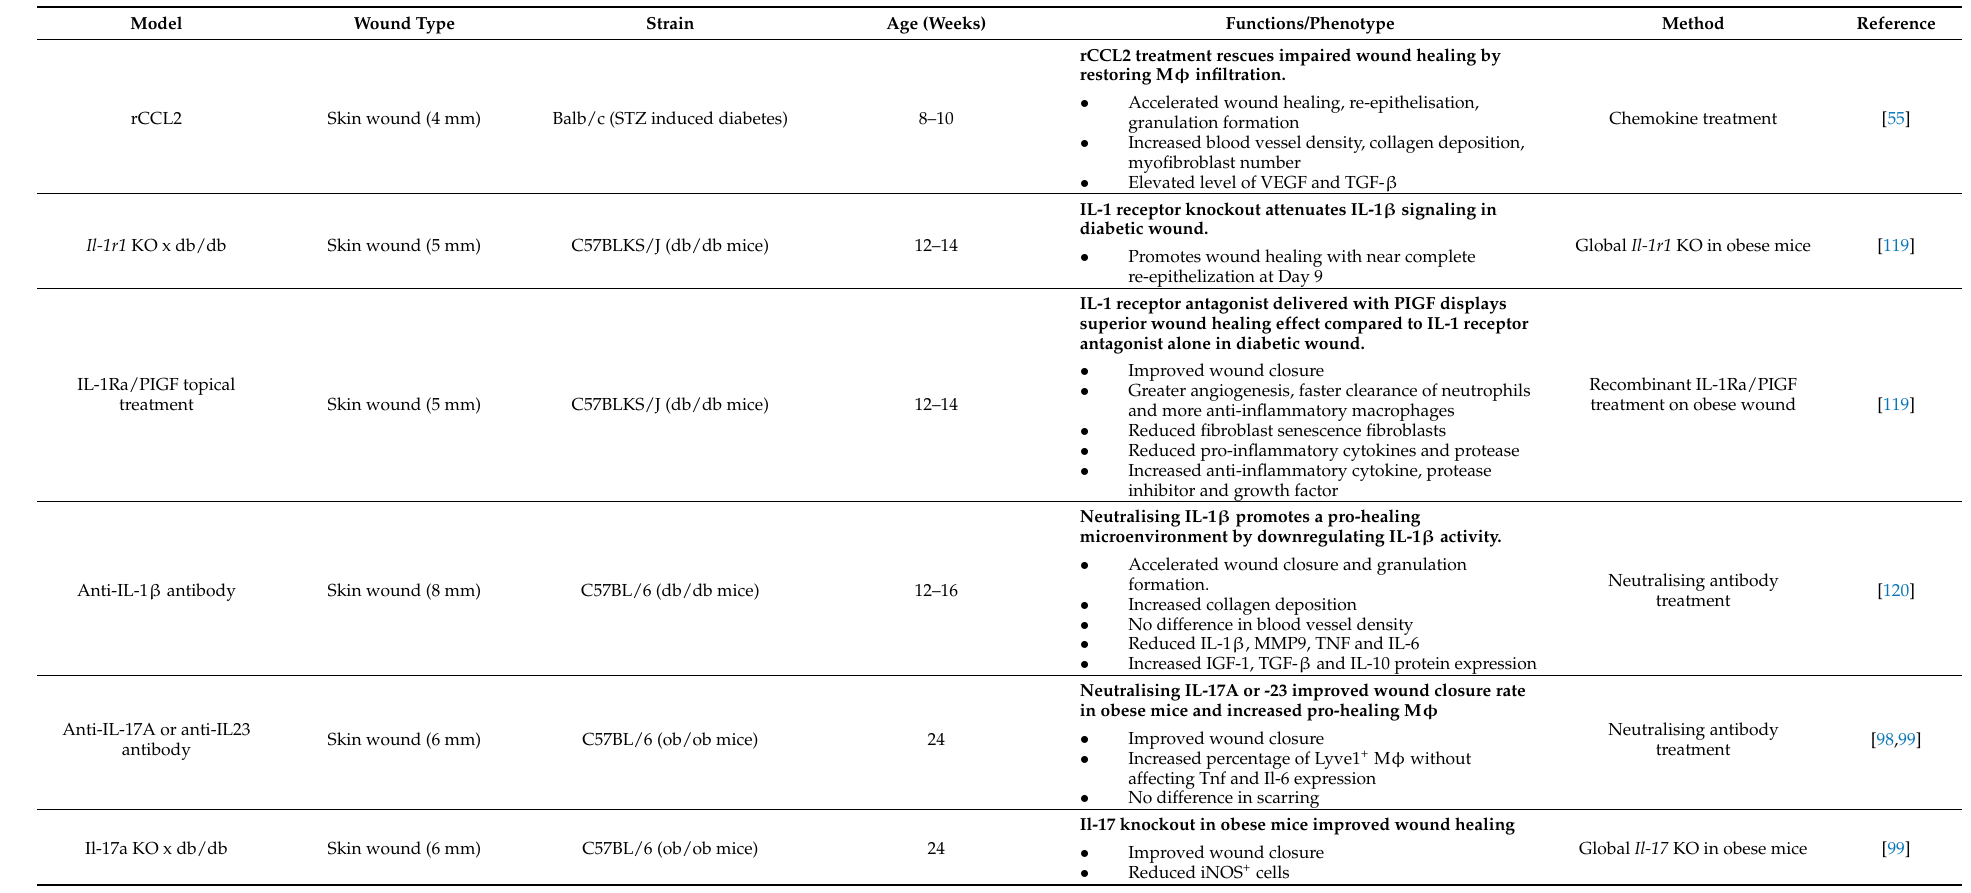
Table 3. Effects of cytokine treatment and cytokine gene knockout on chronic wound-healing